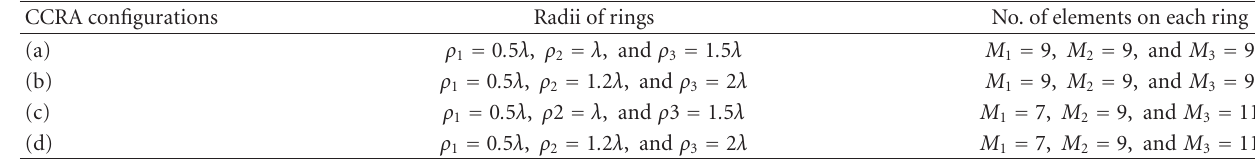
Table 1: The di ff erent CCRA configurations used for obtaining the optimal case.